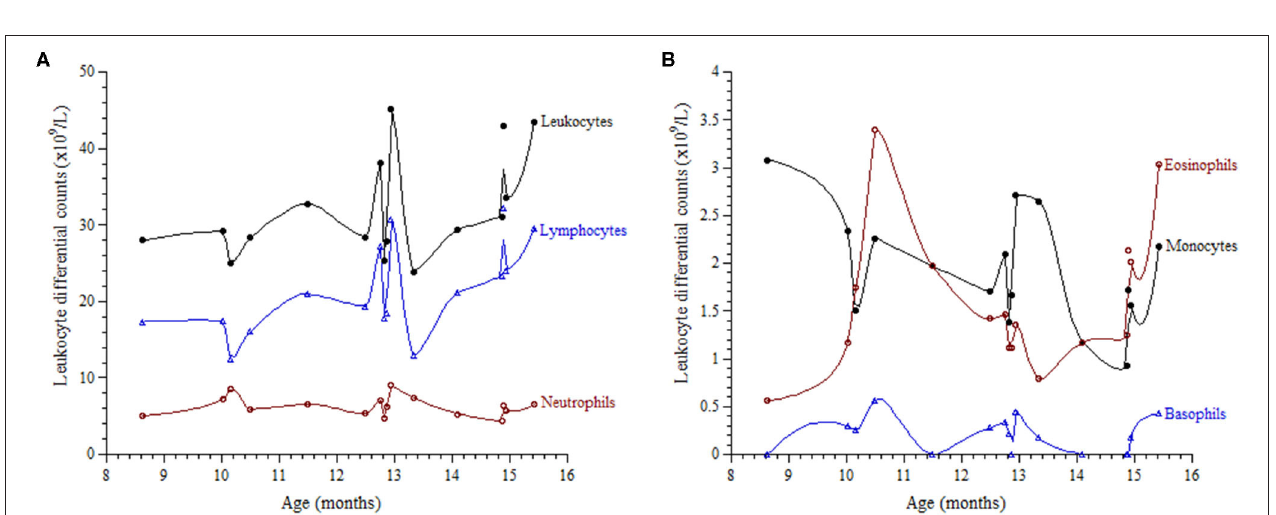
FIGURE 2 | Leukocyte differential counts as function of